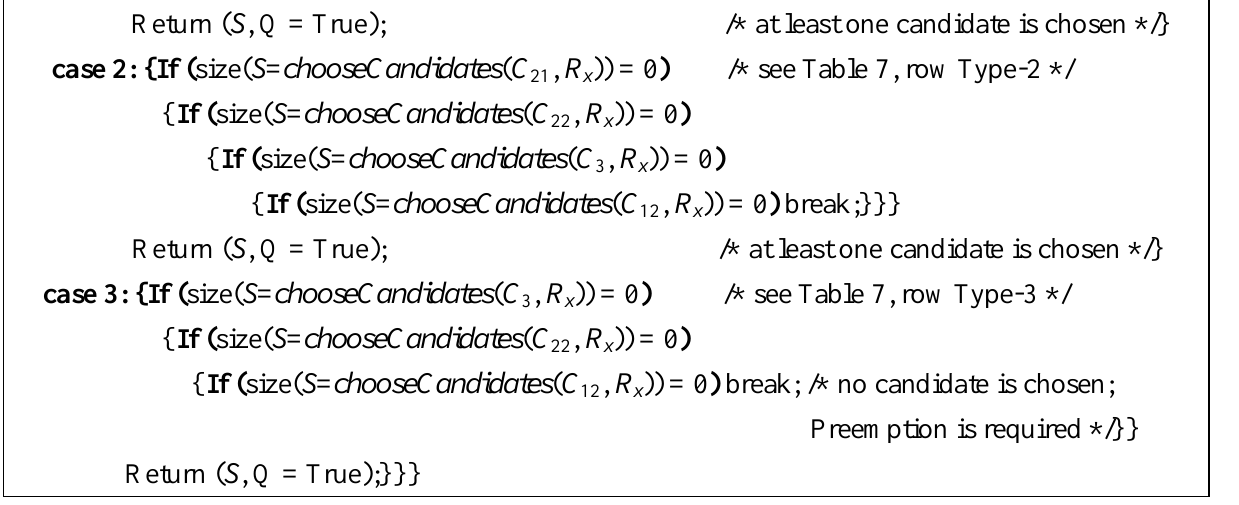
Figure 8. The job allocation algorithm (preemptive